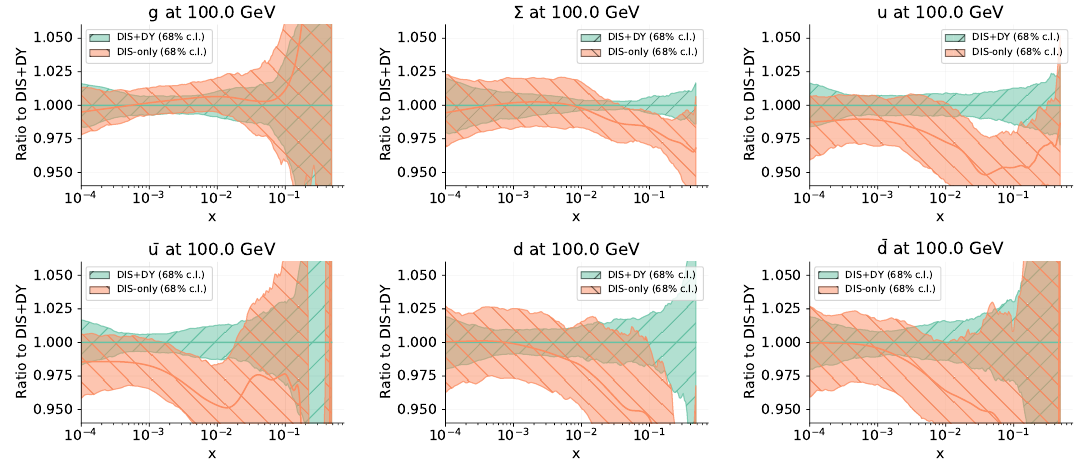
Figure 22 . Same as the upper panels of figure 3 comparing now the baseline SM PDF set used in this work (labelled “DIS+DY”) with the corresponding DIS-only fit. Note that the comparison between the PDF uncertainties in these two fits was already displayed in the lower panels of figure